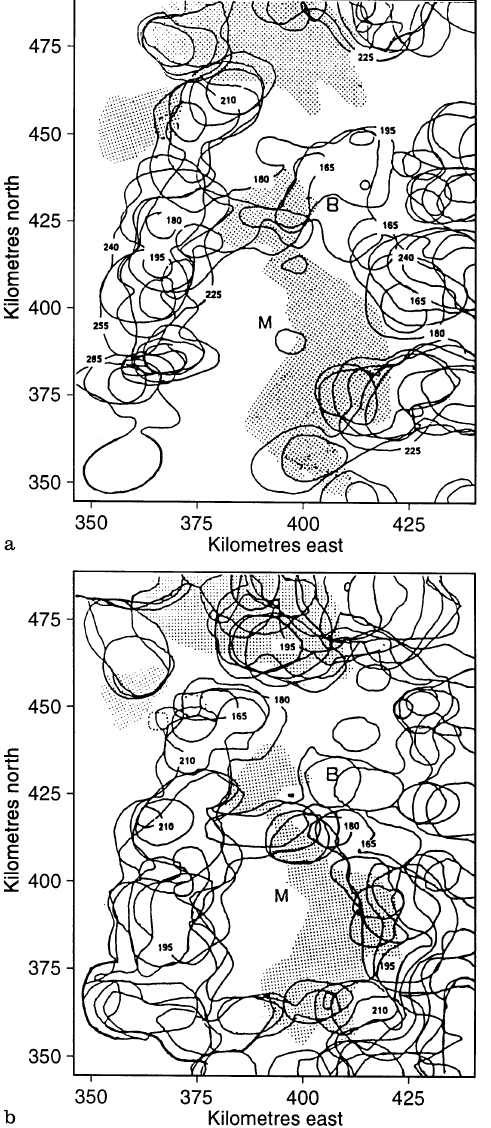
Fig. 7a, b. Overlay of the 0.0625 g/kg contours of rainwater mixing ratio (q (cid:82) ); elevations over 250 m are stippled. M and B refer to Manchester and Bradford/Leeds respectively. The numbers indicate